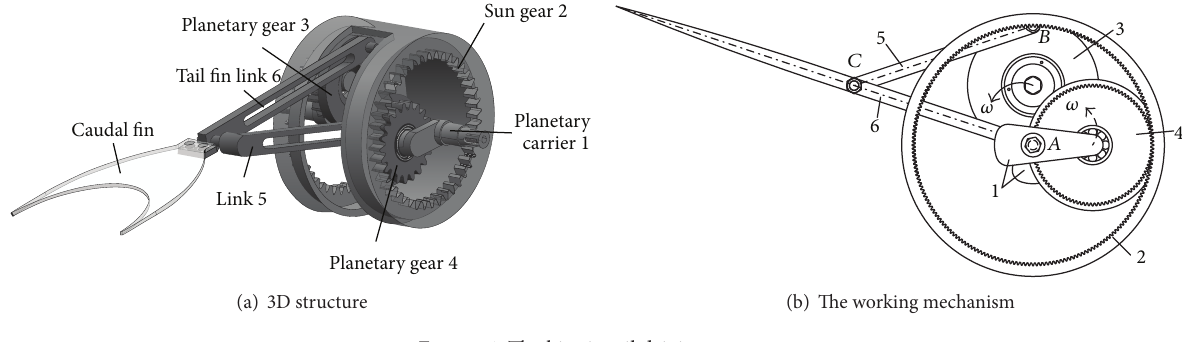
Figure 1: The bionic tail driving system.